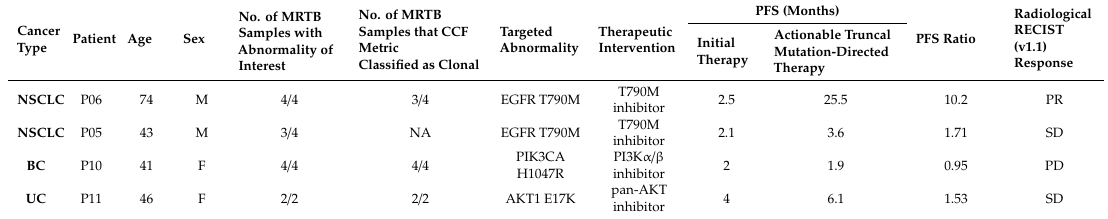
Table 1. Clinical details of patients who received therapy targeting their actionable truncal